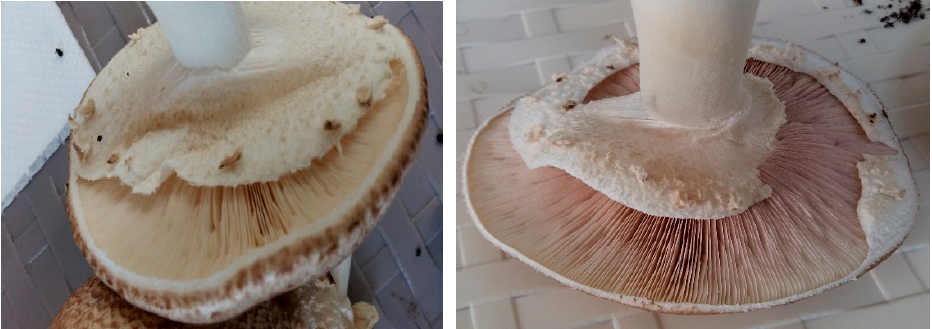
Figure 9. Agaricus blazei Murrill mushrooms hat.